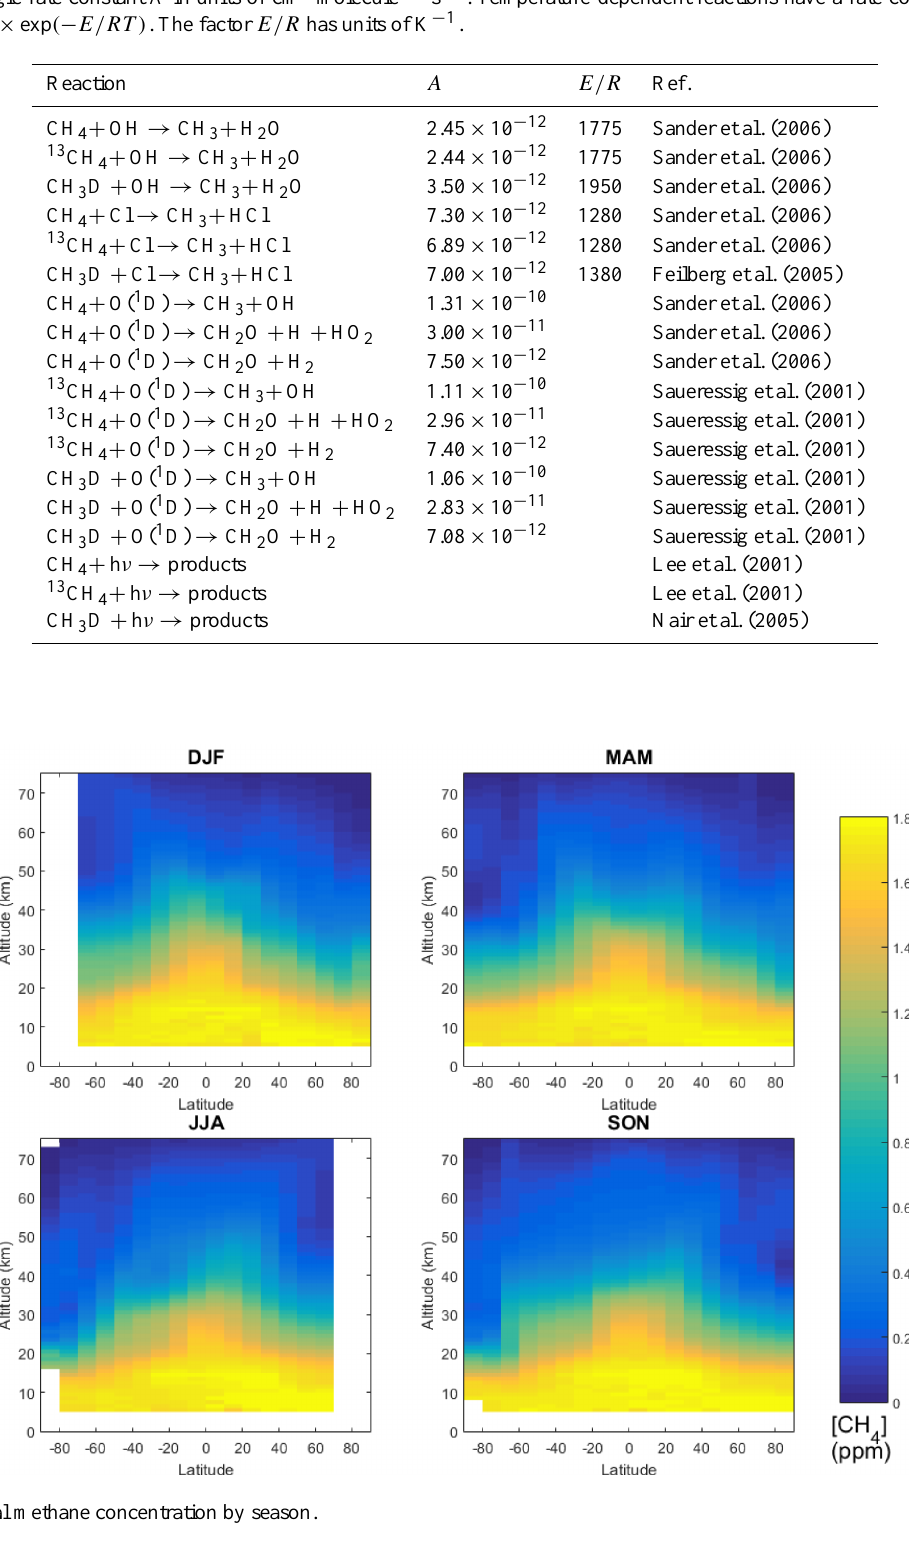
Table 3. Kinetic constants of reactions modified to include the heavy isotopologues of methane used with WACCM. Temperature-independent